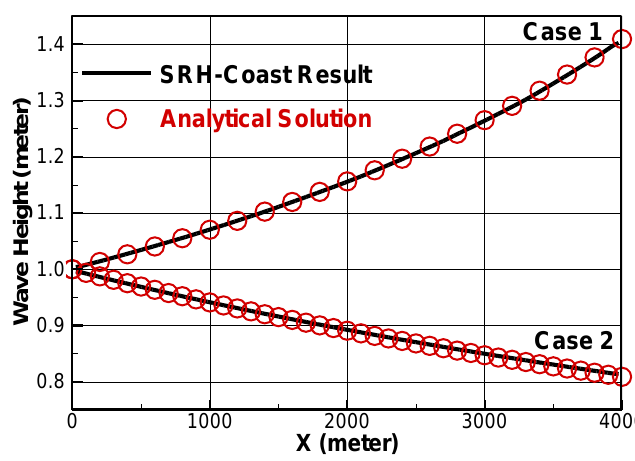
Figure 4. The predicted significant wave height and the analytical solution for cases 1 and 2.